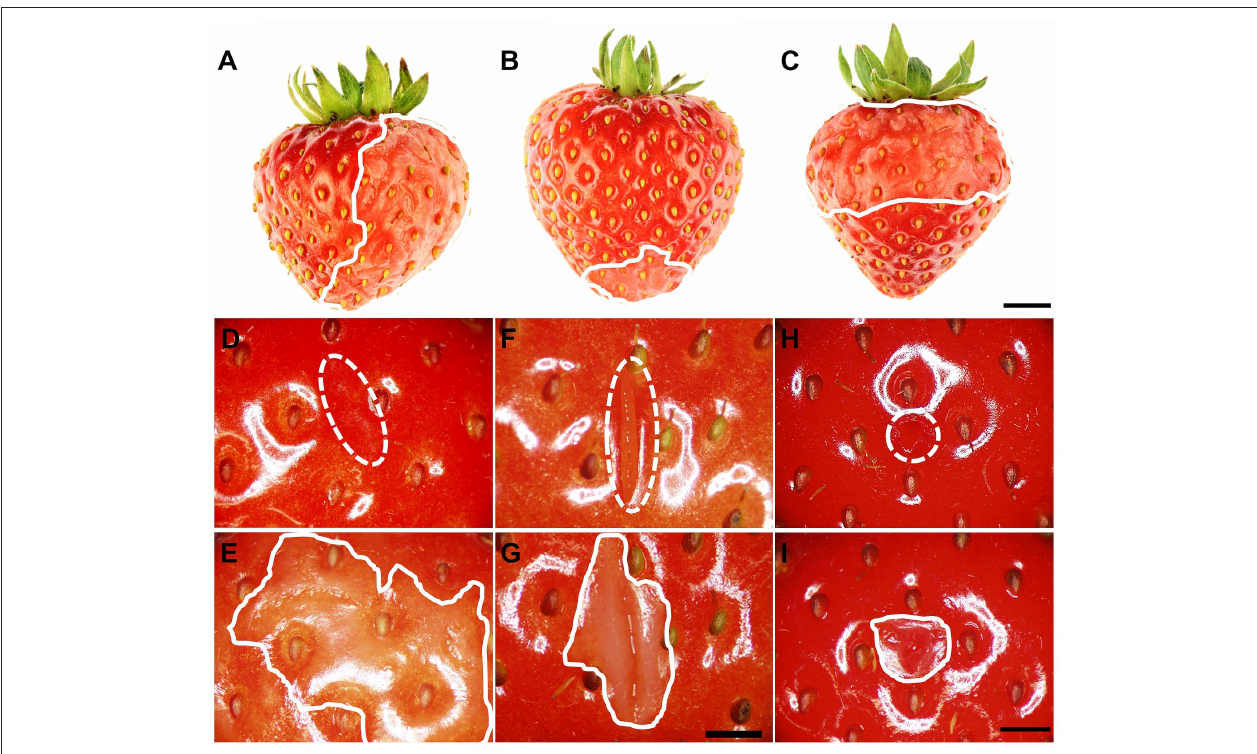
FIGURE 2 | (A–C) Induction of local water soaking symptoms by partial immersion of a strawberry fruit in water. (A) Half of the fruit (long axis horizontal), (B) tip or (C) calyx end of the fruit (long axis vertical). Water soaking following abrasion of the cuticle ( ∼ 10 mm 2 ), (D,E) incision of the skin using a razor blade (5mm length × 3mm depth), (F,G) and puncture of the skin using a dissection needle (1.6mm diameter and 5mm depth) (H,I) . (D,F,H) images taken immediately after wounding ( t = 0h); (E,G,I) images of same area taken after a 3-h incubation in deionized water. The fruit was submerged completely. The water-soaked area around the wound averaged 179.4 ± 48.8 mm 2 (E) , 37.5 ± 5.7 mm 2 (G) , and 20.7 ± 4.2 mm 2 (H) . Scale bar in (A–C) = 5mm and (D–I) = 2.5mm. The dashed white line indicates the wound area, and the solid white line indicates the margin of the water-soaked area. The area outside of the solid white line was also in contact with deionized water